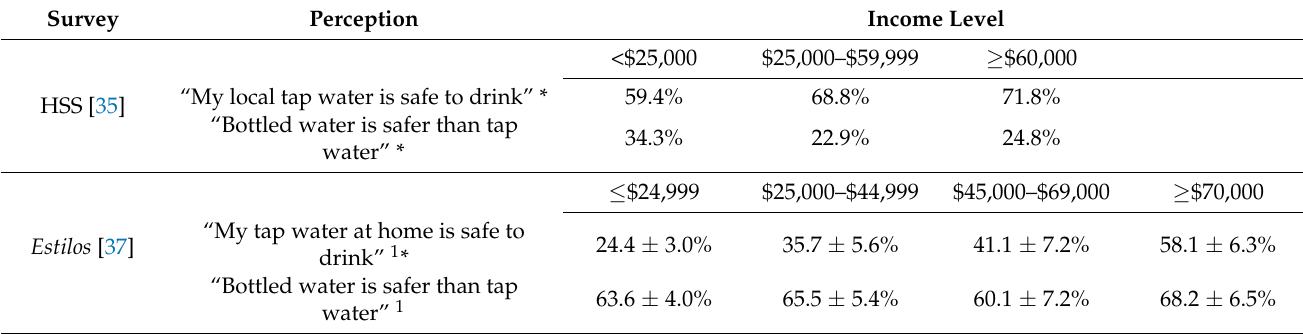
Table 6. Prevalence of agreement with perceptions by household income level among survey samples.